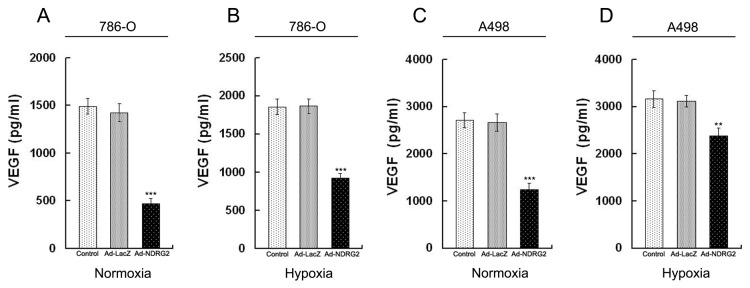
Effect of Ad-NDRG2 on VEGF secretion in renal cancer cells under normoxia or hypoxia.(A and B) 786-O, Ad-LacZ-786-O and Ad-NDRG2-786-O cells were incubated under normoxia and hypoxia for 24 h. After incubation, the media were analyzed for VEGF levels by ELISA assay. (C and D) A498, Ad-LacZ- A498 and Ad-NDRG2- A498 cells were incubated under normoxia and hypoxia for 24 h. After incubation, the media were analyzed for VEGF levels by ELISA assay. The data were the mean ± standard deviation (SD) for three independent experiments. Statistical significance was assessed with one-way ANOVA. ** or *** indicates P < 0.01 or P < 0.001, respectively, when compared with the Ad-LacZ group.